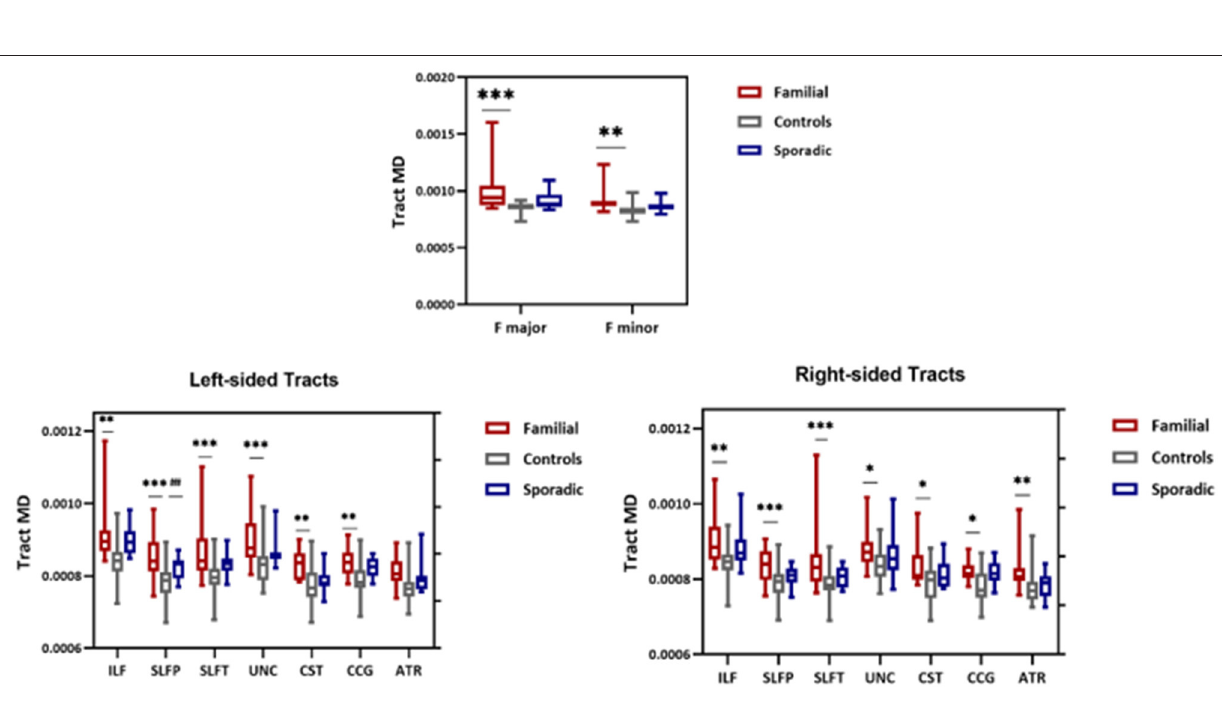
Frontiers in Neurology |